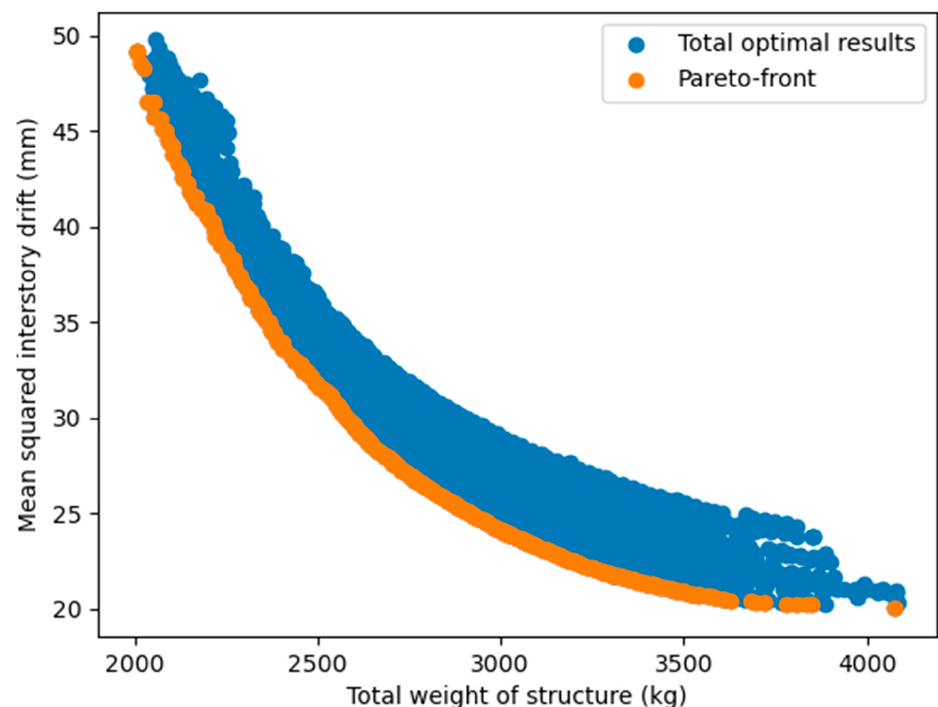
Figure 4. The approximate Pareto-front of the 10-bar truss.